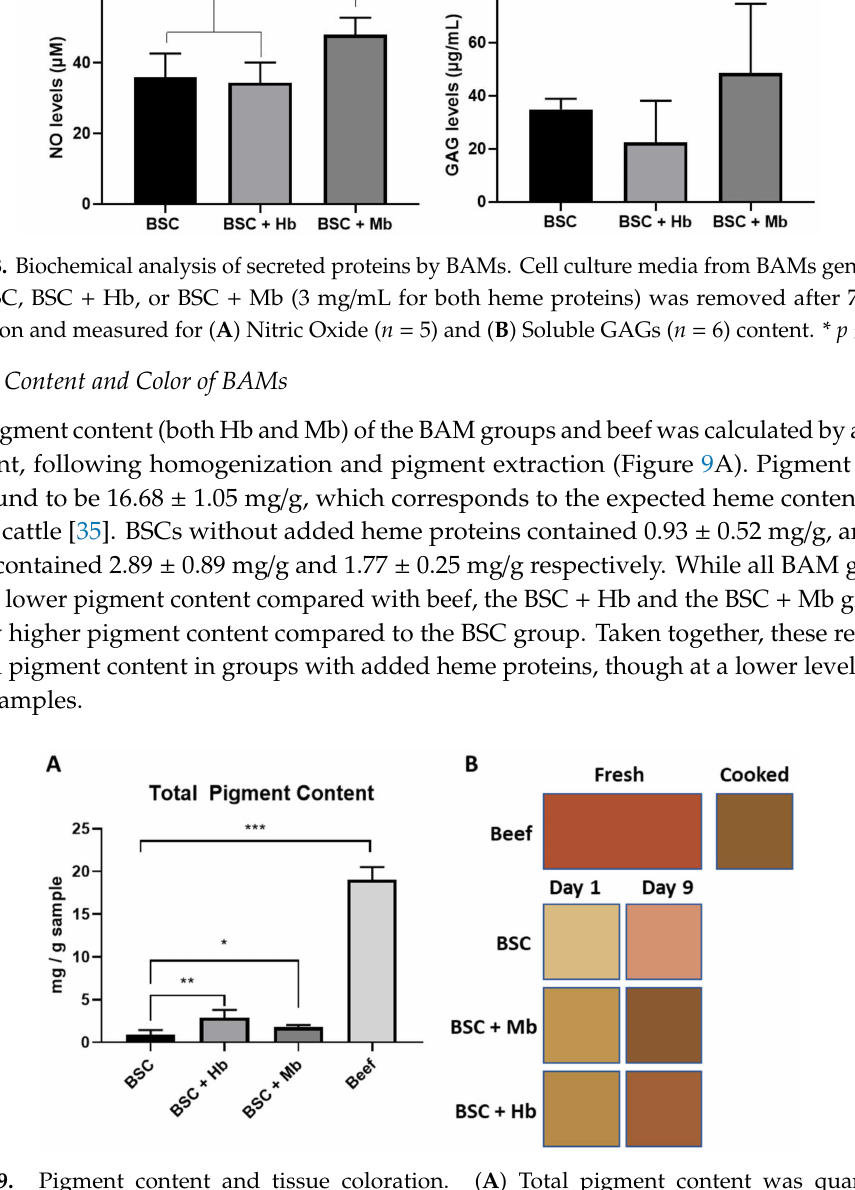
Figure 9. Pigment content and tissue coloration. ( A ) Total pigment content was quantified spectroscopically by homogenization of BAMs generated from BSC, BSC + Hb, or BSC + Mb (3 mg / mL for both heme proteins) and beef ( n = 6 for all groups) in a sodium phosphate bu ff er, leading to pigment release into the solution. The amount of pigment was calculated from a standard of Hb and Mb. ( B ) Average L*a*b* values for BSC ( n = 6), BSC + Hb ( n = 5), and BSC + Mb ( n = 6) and beef ( n = 9) are displayed. Beef color is presented as fresh or cooked BAM color after incubation of one day or nine days. * p ≤ 0.05, ** p ≤ 0.01, *** p ≤